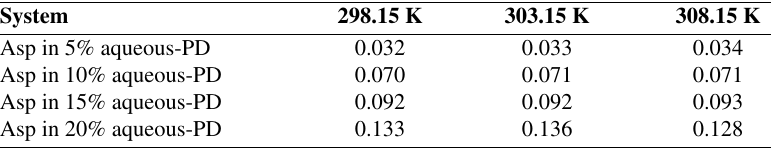
Table 9. Viscosity B-coefficients of transfer, B ent